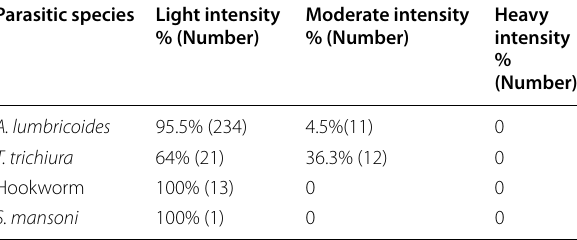
Table 3 Intensity of total parasitic infections among study species of soil-transmitted helminths than those who participants, Gedeb District, Gedeo Zone, southern Ethiopia, 2021 Parasitic species Light intensity Moderate intensity Heavy % (Number) % (Number)